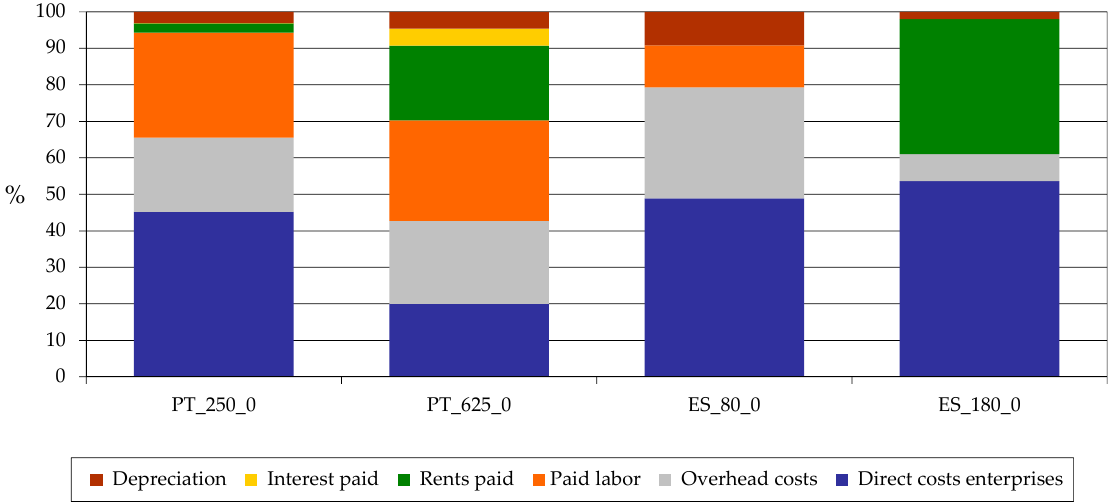
Figure 5. Whole farm costs in % values. Source: model results.